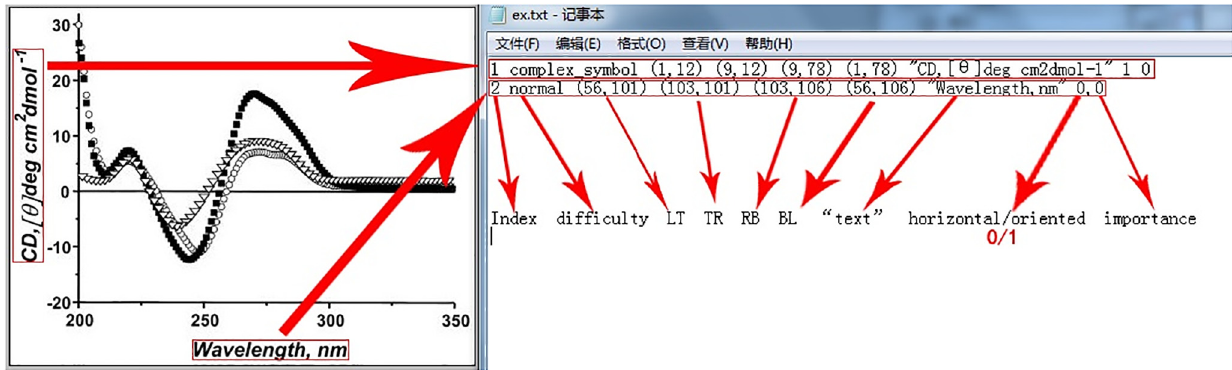
Fig 4. An example for the annotation information. Each figure in the database corresponds to a ground truth file (we use a “ .txt ” file to store the annotation information), in which each line records the information of the text in the corresponding text